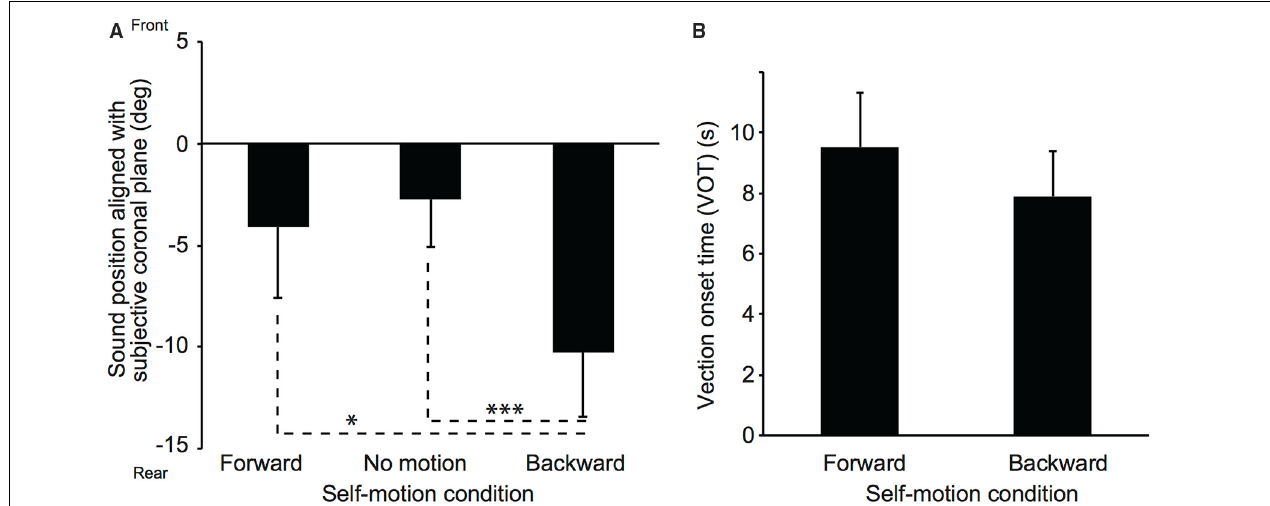
FIGURE 4 | Effectofconstantvelocityonauditorylocalization(A)andonvectiononsetlatency(B)inExperiment2. Thesimulatedself-motionvelocitywas 1.5m/s. Error bars denote standard errors. Note that the participants experienced self-motion perception but were not physically moved. ∗ p < 0 . 05; ∗∗∗ p < 0 . 005.